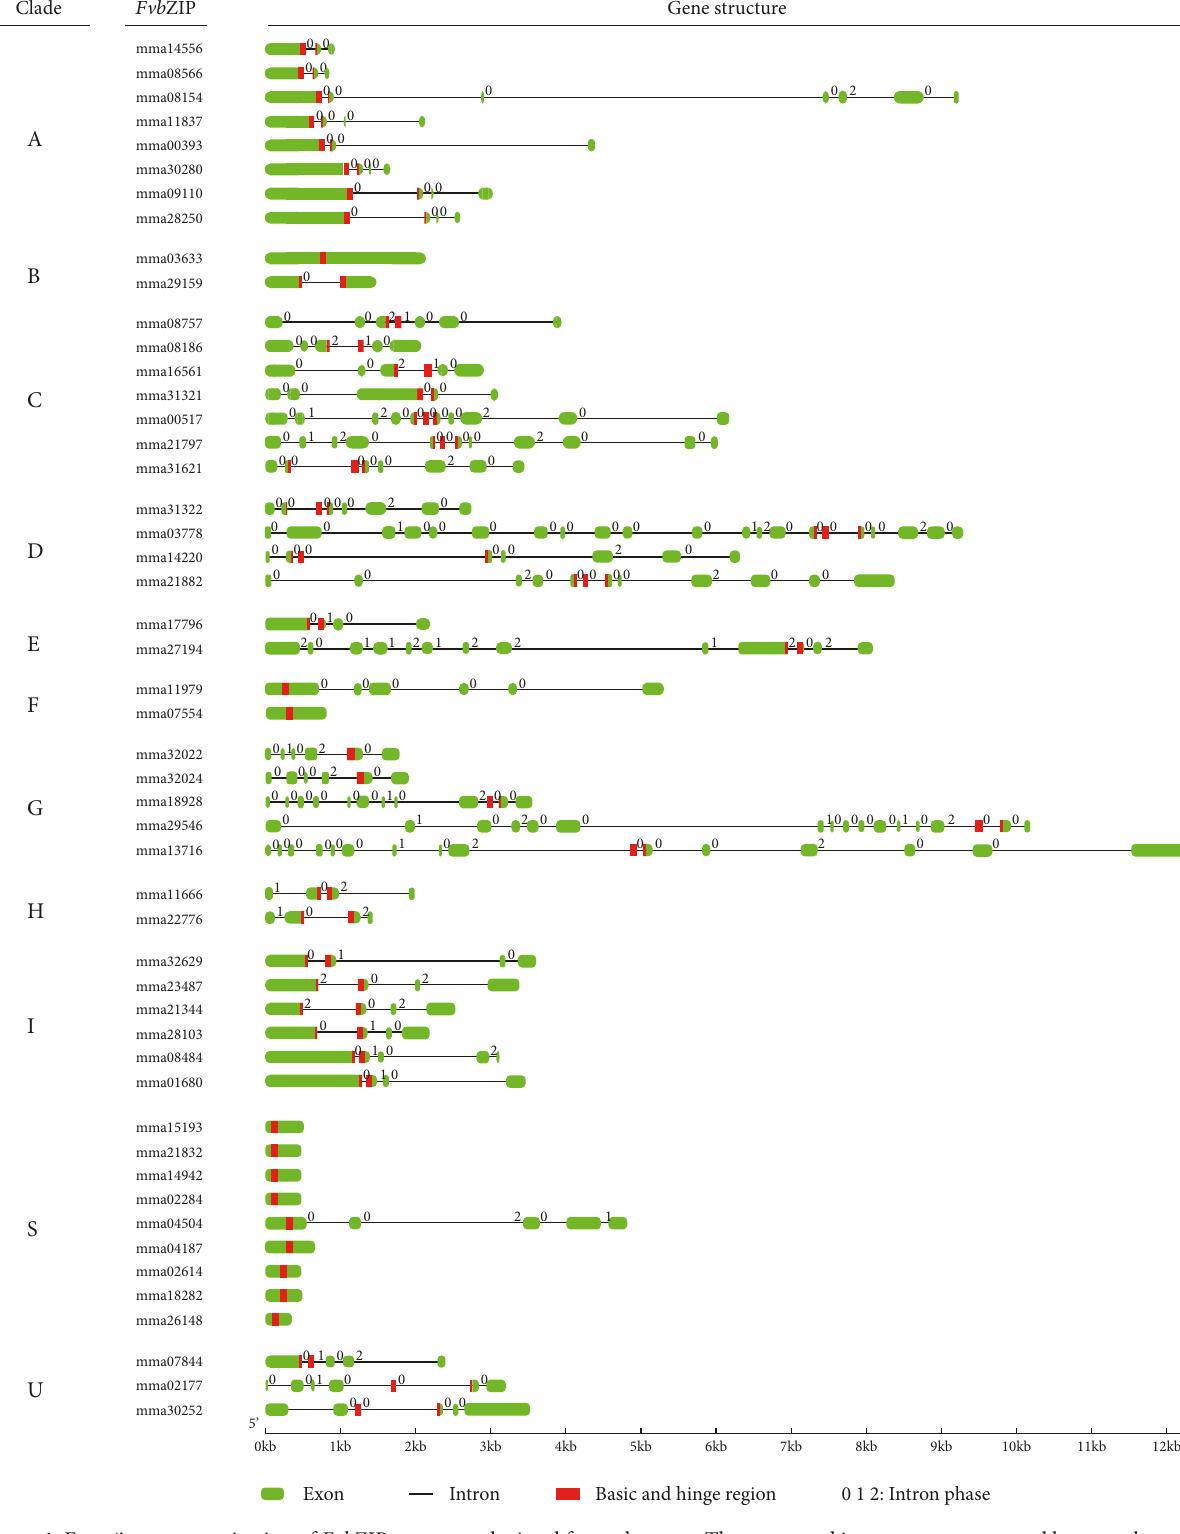
Figure 1: Exon/intron organization of FvbZIP genes was depicted for each group. The exons and introns are represented by green boxes and black lines, respectively. The red boxes denote the basic and hinge region of bZIP domain. The numbers above line denote the splicing phase. The numbers “ 0 ” and “ 2 ” denote di ff erent splicing phases, “ 0 ” means splicing occurred after the third nucleotide of the codon, and “ 2 ” means splicing occurred after the second